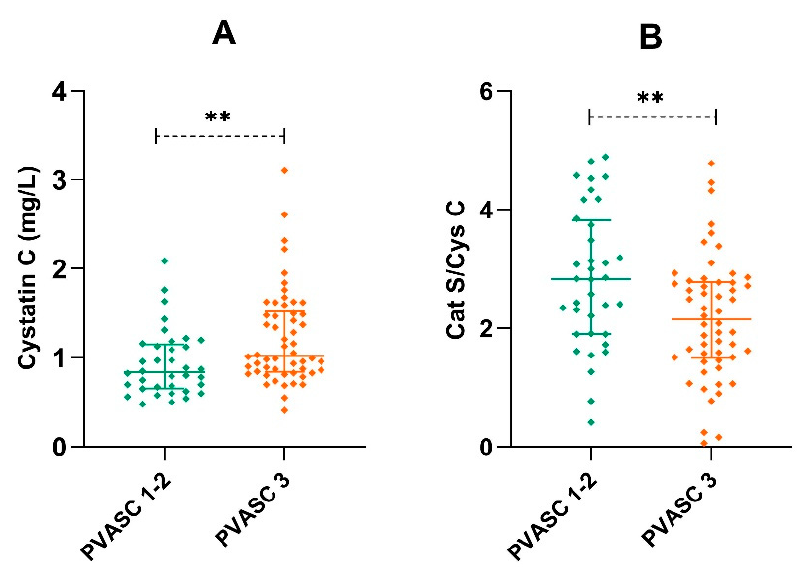
Figure 1. Serum Cys C ( A ), Cat S ( B ) concentrations and the Cat S/Cys C ( C ) ratio in the moderate and severe PAD groups. * p < 0.05, *** p < 0.001.